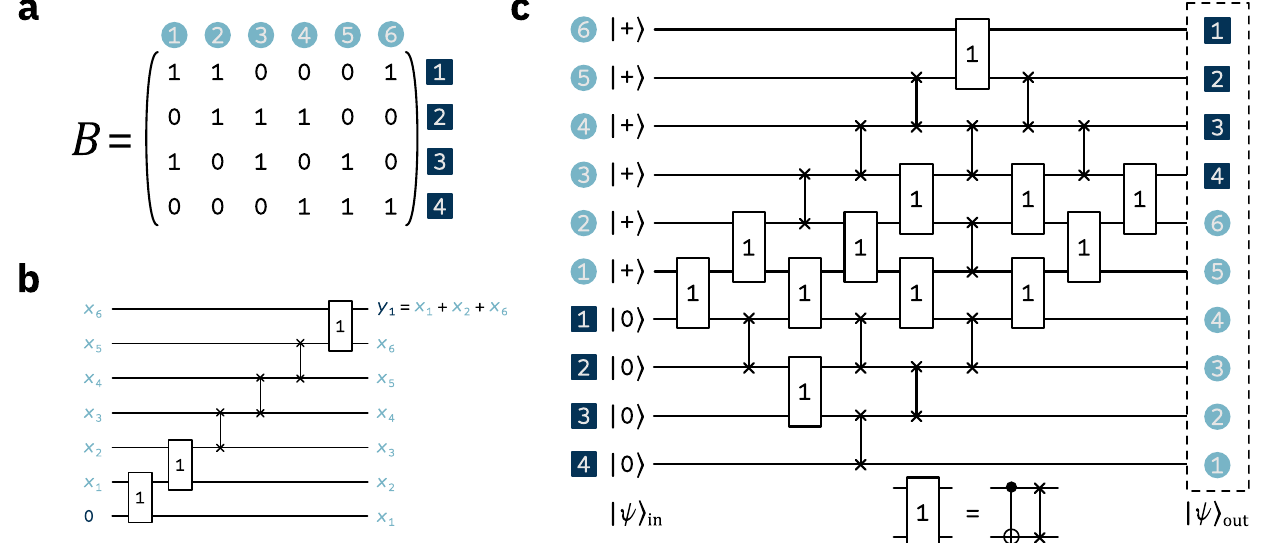
Fig.1|Anexampleofsystem(Eq.(1))with L =6and R =4.a Thematrix B ofEq.(1), where each column represents a variable and each row represents an equation. b The fi rstlinearequationin B compiledasacircuit.Thegatelabelled “ 1 ” isaCNOT followed by a SWAP, as shown in the inset of ( c ). We use this circuit design to construct the full quantum circuit for B x = y . c The quantum circuit built from B .